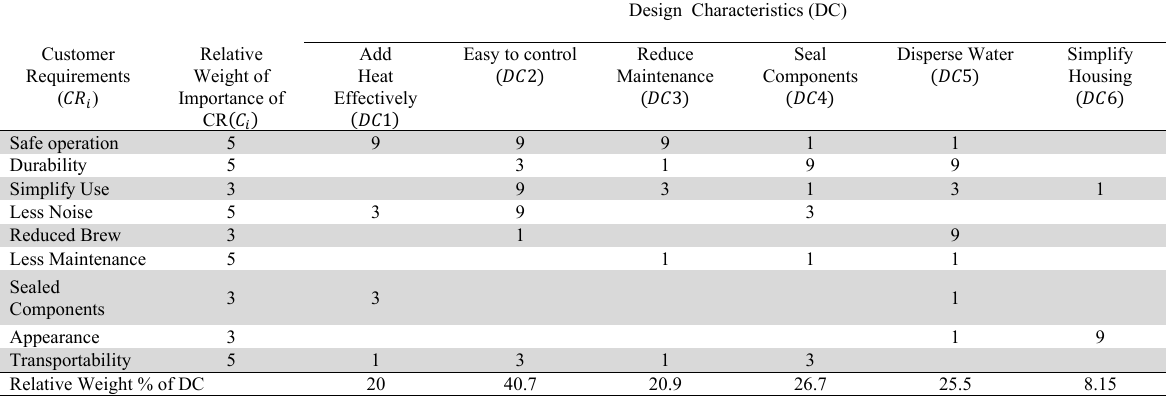
Customer Requirements to Design Characteristics Mapping